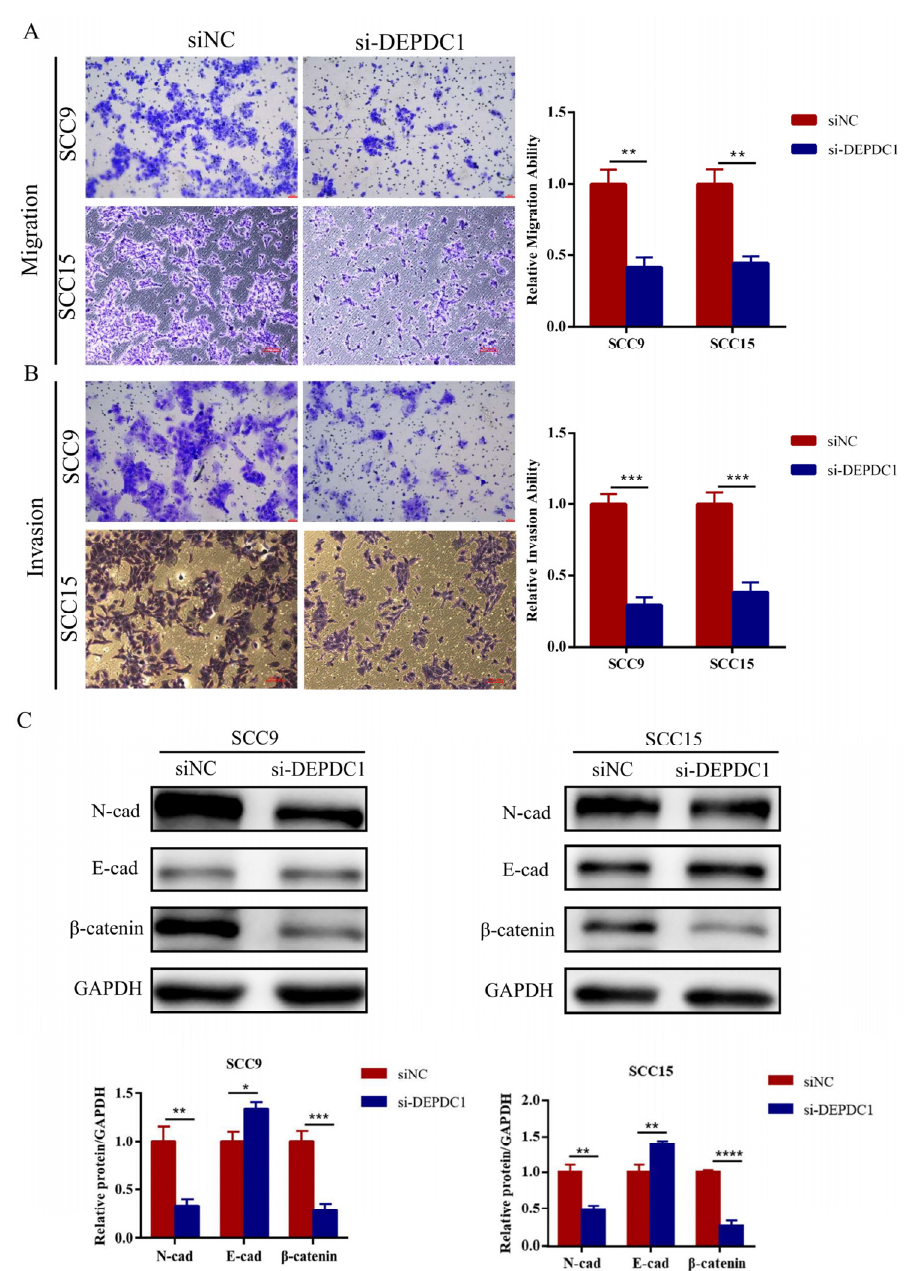
Figure 4. Knockdown of DEPDC1 inhibited the migration and invasion of OSCC. ( A ); ( B ), The migration (SCC9 p = 0.0012, SCC15 p = 0.0010) and invasion abilities (SCC9 p = 0.0002, SCC15 p = 0.0005) of SCC9 and SCC15 were inhibited after knockdown of DEPDC1. ( C ); Knockdown of DEPDC1 resulted in a decrease in N-cad (SCC9 p = 0.0024, SCC15 p = 0.0022) and β -catenin (SCC9 p = 0.0007, SCC15 p < 0.0001), and an increase in E-cad (SCC9 p = 0.0102, SCC15 p = 0.0040). Error bars in the graphs represent S.D. N-cad: N-cadherin, E-cad: E-cadherin, siNC: negative control of siRNA, si-DEPDC1: knockdown of DEPDC1. Significant differences were considered at p < 0.05 *; p < 0.01 **; p < 0.001 ***; and p < 0.0001 ****.